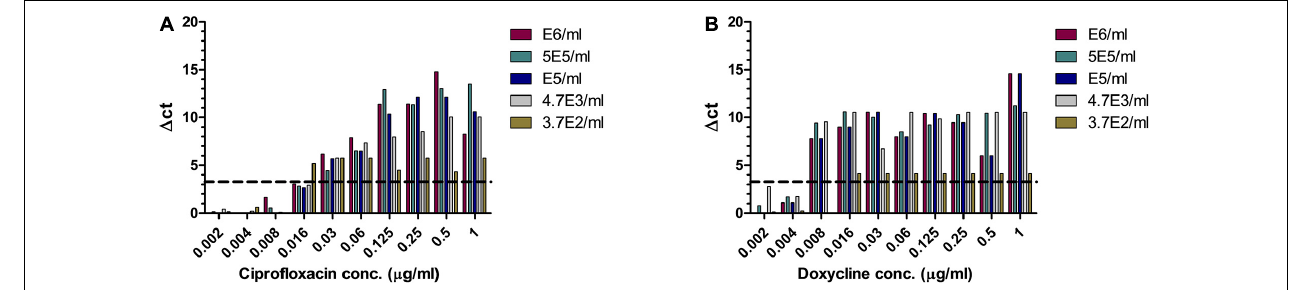
FIGURE 3 | MIC determination of whole blood samples spiked with B. anthracis . Human whole blood samples inoculated with different concentrations of B. anthracis (cfu/ml) were subjected to AST for ciprofloxacin (A) and doxycycline (B) by the MAPt analysis. MICs were determined, as described in the Materials and Methods section, by the threshold (cid:49) CT =